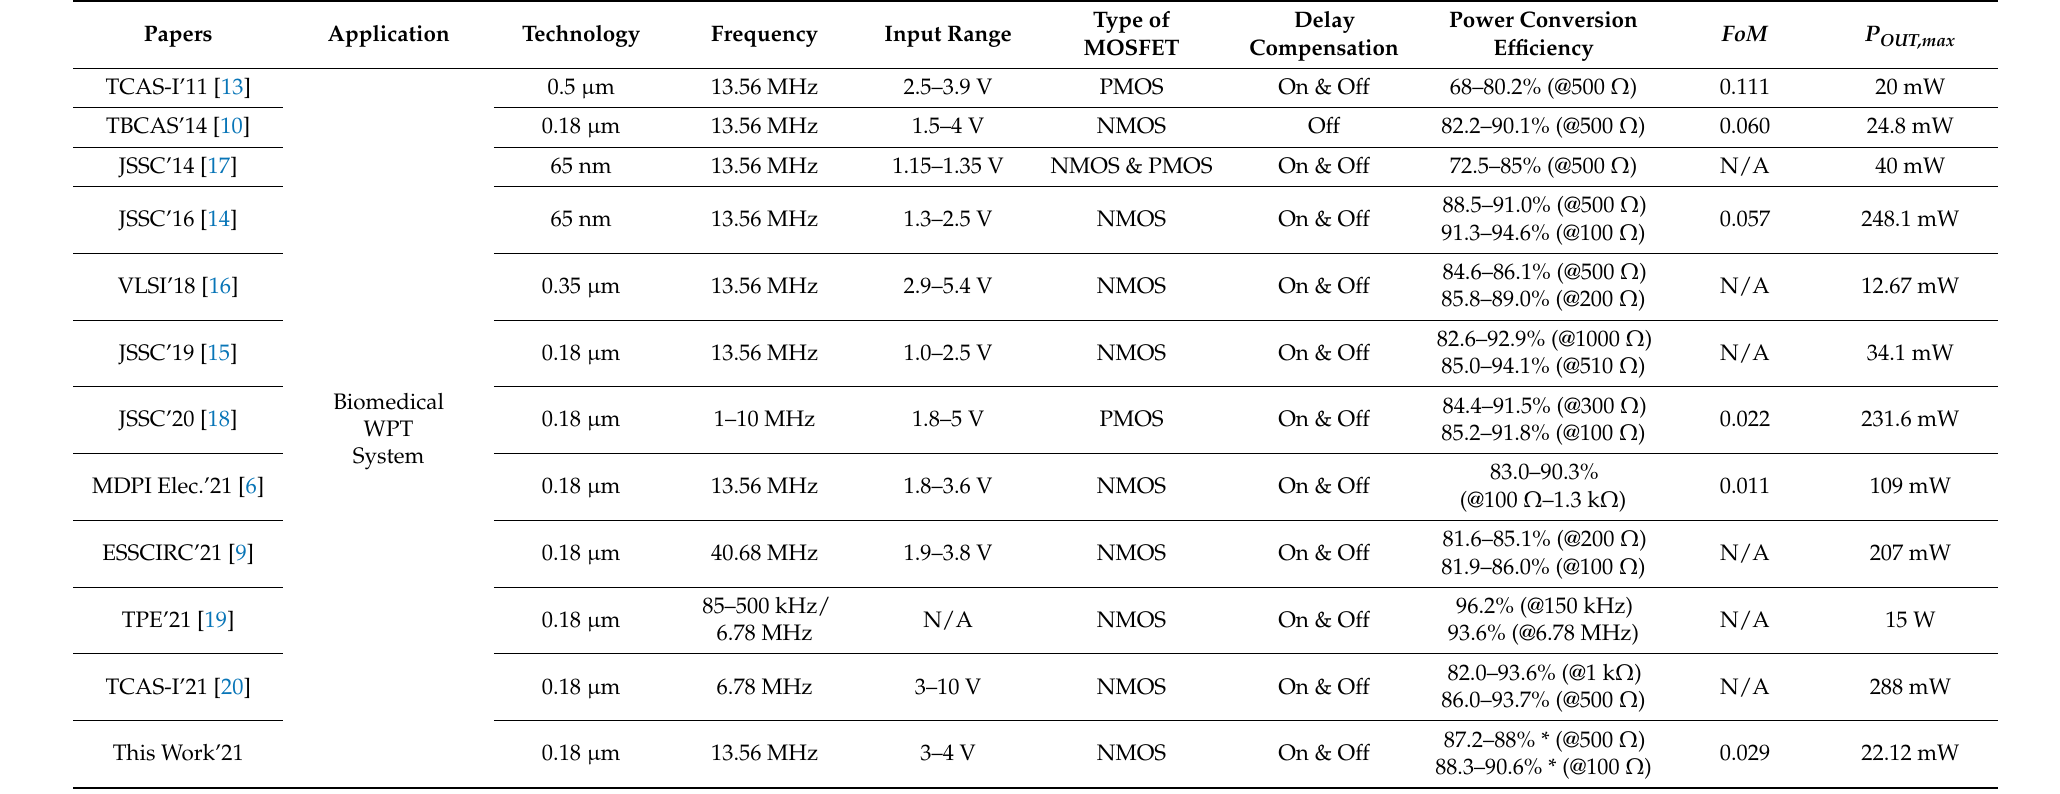
Table 2. Comparisons with previous active